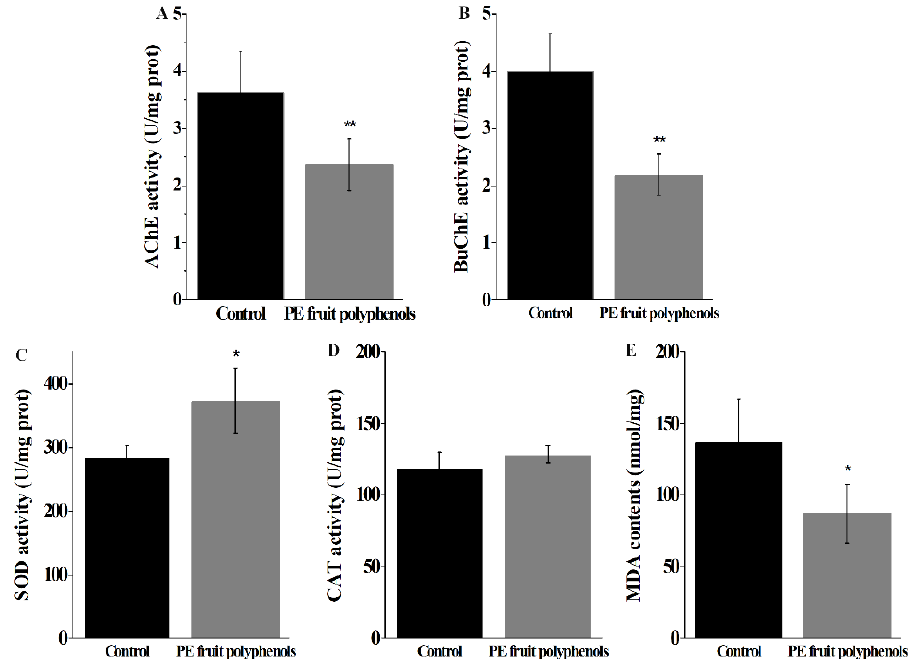
Figure 5. The effect of PE fruit polyphenols on the activity of AChE ( A ), BuChE ( B ), SOD ( C ), CAT ( D ) and the contents of MAD ( E ) in C. elegans . * p < 0.05 was significant from the control, and ** p < 0.01 was extremely significant from the